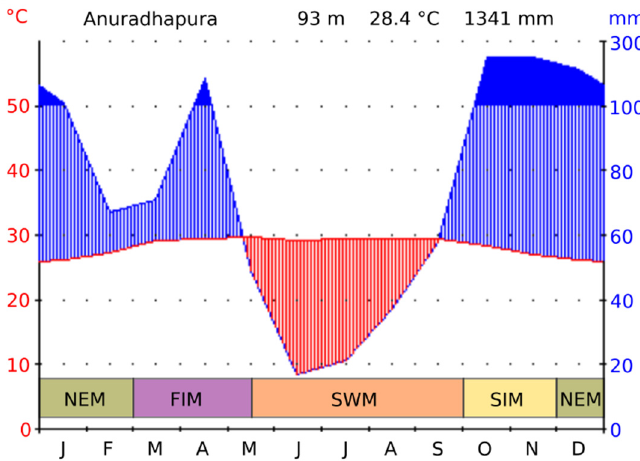
Figure 2. Climate graph for Anuradhapura meteorological station (8.35° N; 80.38° E), including the four climate seasons in Sri Lanka: the North-East Monsoon (NEM), the First Inter Monsoon (FIM), the South-West Monsoon (SWM) and the Second Inter Monsoon (SIM). Database: daily climate data from 01/1994–08/2014 from Department of Meteorology Sri Lanka; graphic generated by Klima 0.9 [20].